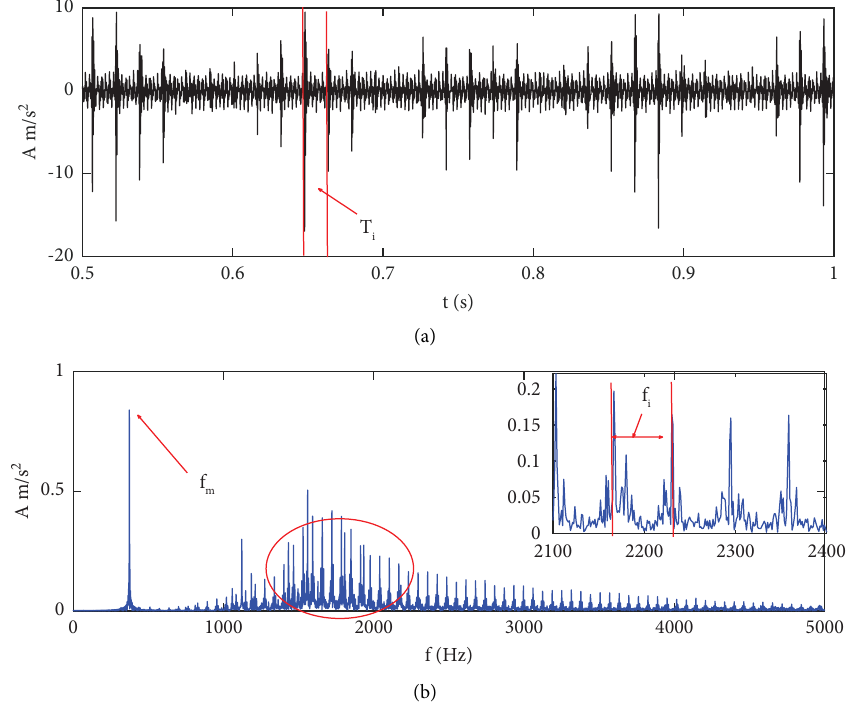
Figure 17: Te response of the bearing node of the driven shaft with inner fault: (a) the time domain; (b) the frequency